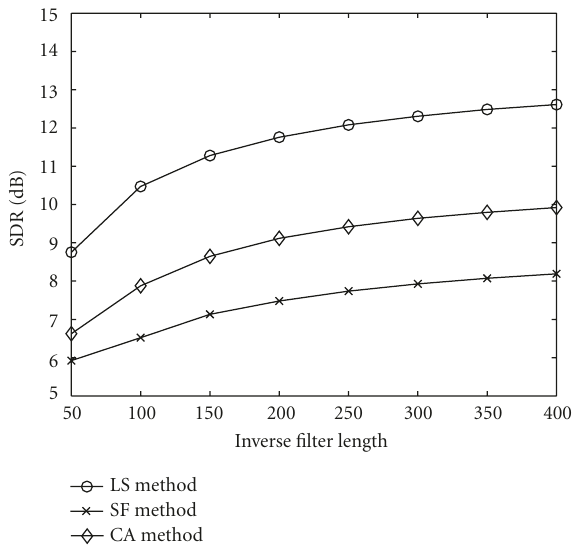
Figure 5: Mean signal-to-distortion ratio (SDR) at di ff erent inverse filter lengths for the three methods: the least-squares method (LS), the single-filter structure method (SF), and the CAPZ method (white noise added to HRTF).